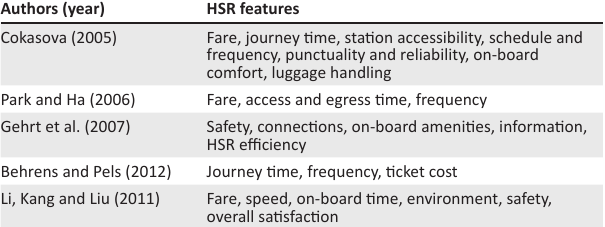
TABLE 1: Summary of high-speed rail features used in previous